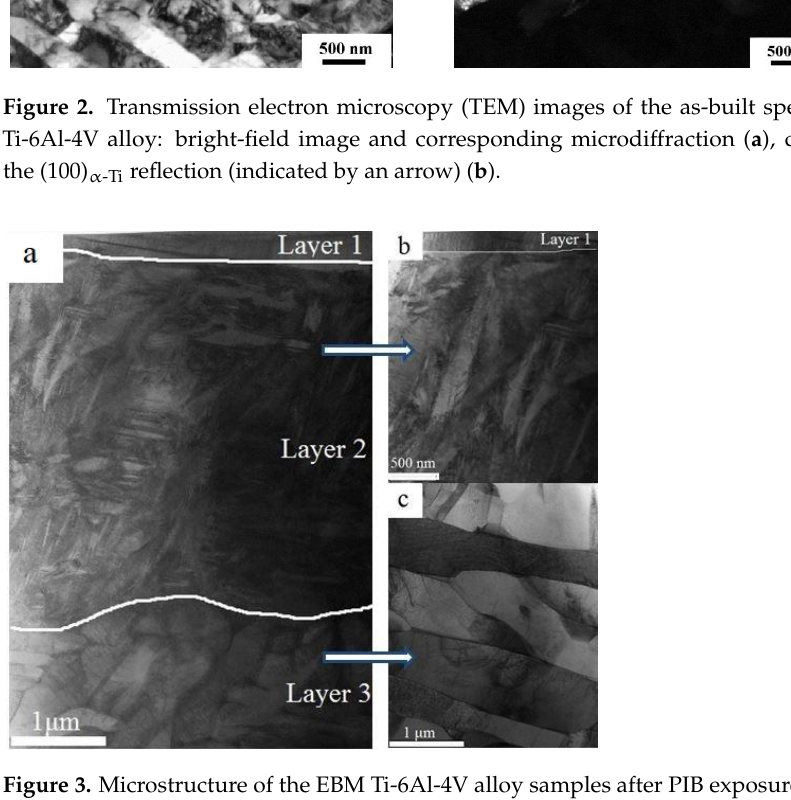
Figure 3. Microstructure of the EBM Ti-6Al-4V alloy samples after PIB exposure at various depths: characteristic zones with different microstructure designated as Layers 1, 2, 3 ( a ), scanning trans- mission electron microscopy (STEM) images of Layers 1 and 2 ( b ), STEM image of Layer 3 ( c ).